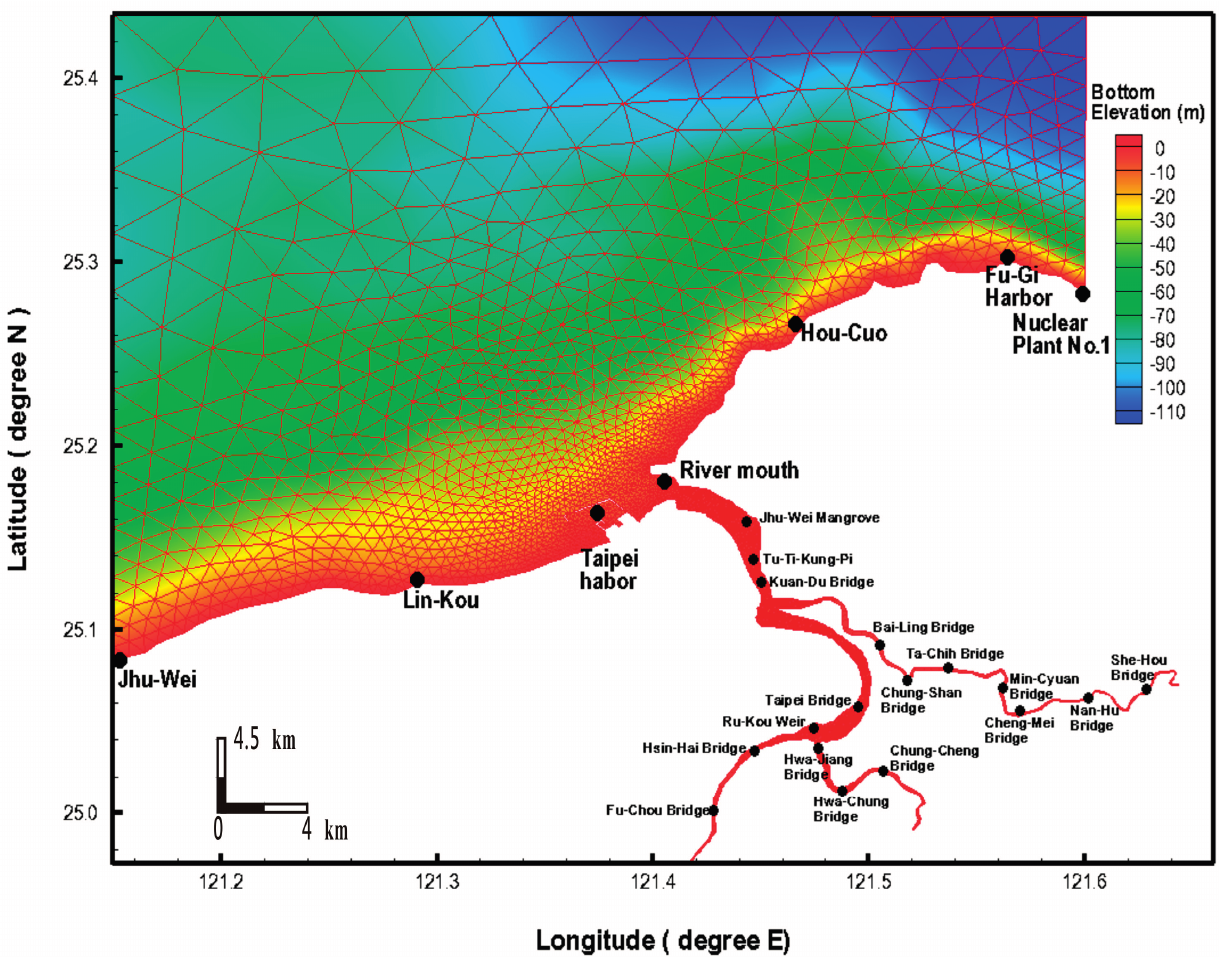
Figure 2. Topography of the Danshuei River estuarine system and its adjacent coastal and unstructured grid for the computational